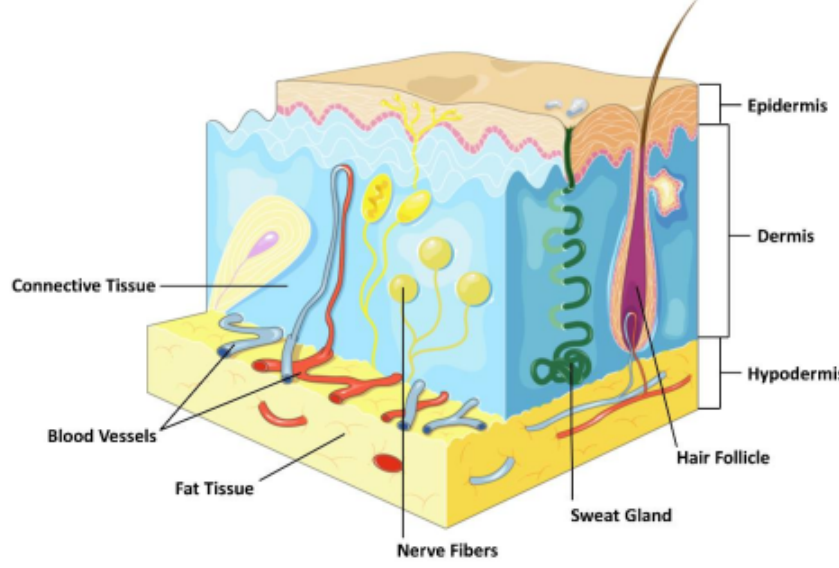
Figure 1. The structure of the